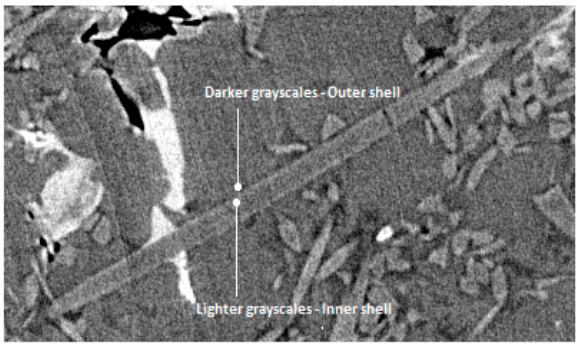
Figure 2. Local phase contrast at an Al 2 O 3 fiber/Al matrix interface.